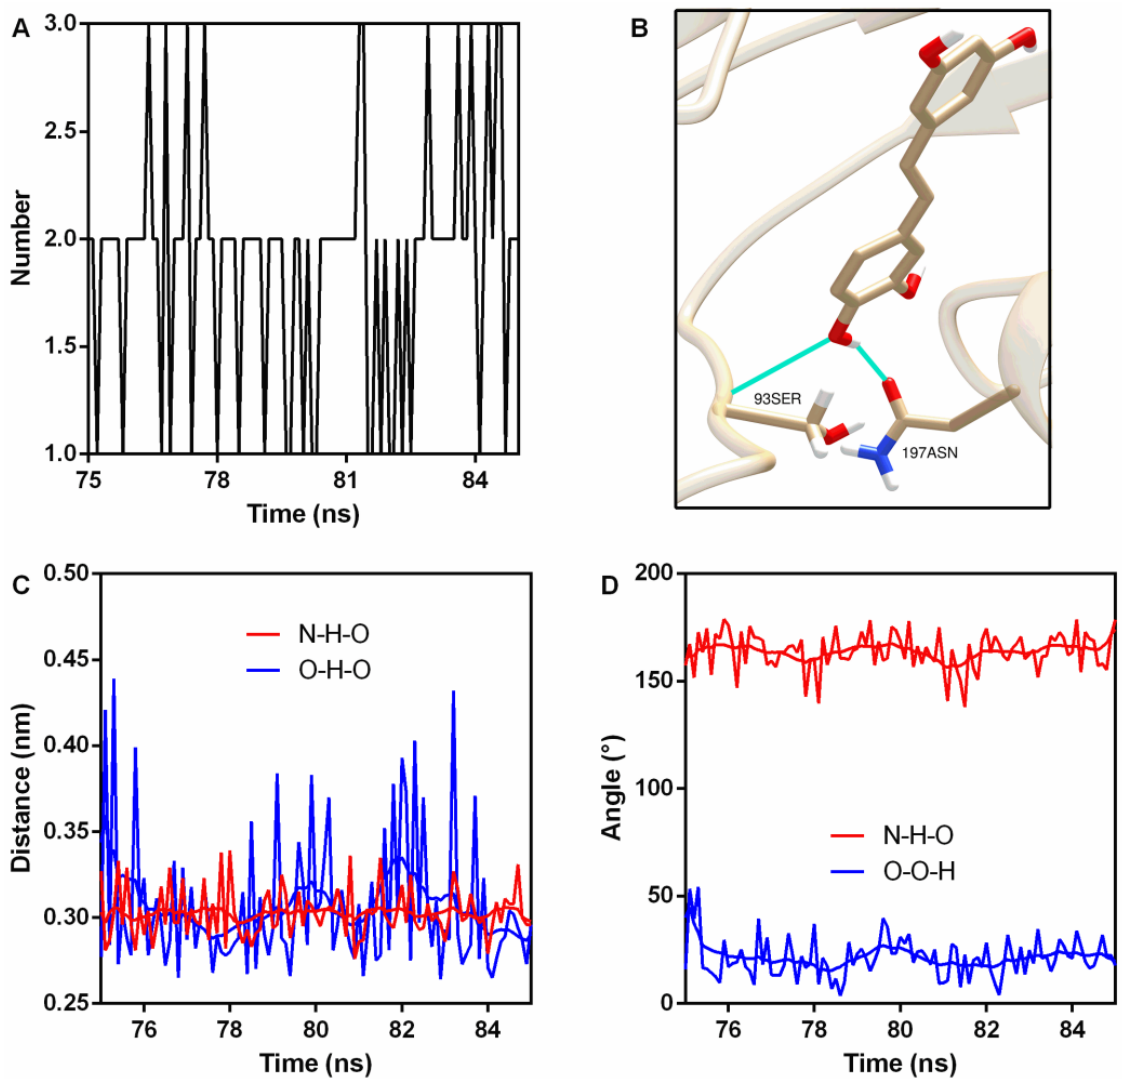
Figure 5. Hydrogen bonds were generated during binding. ( A ) The number of hydrogen bonds during the binding process. ( B ) The sites of hydrogen bonding between piceatannol and PFO. ( C ) The distance between the donor and receptor. ( D ) Angle analysis. Table 2. The H-bonds details between PFO and piceatannol.